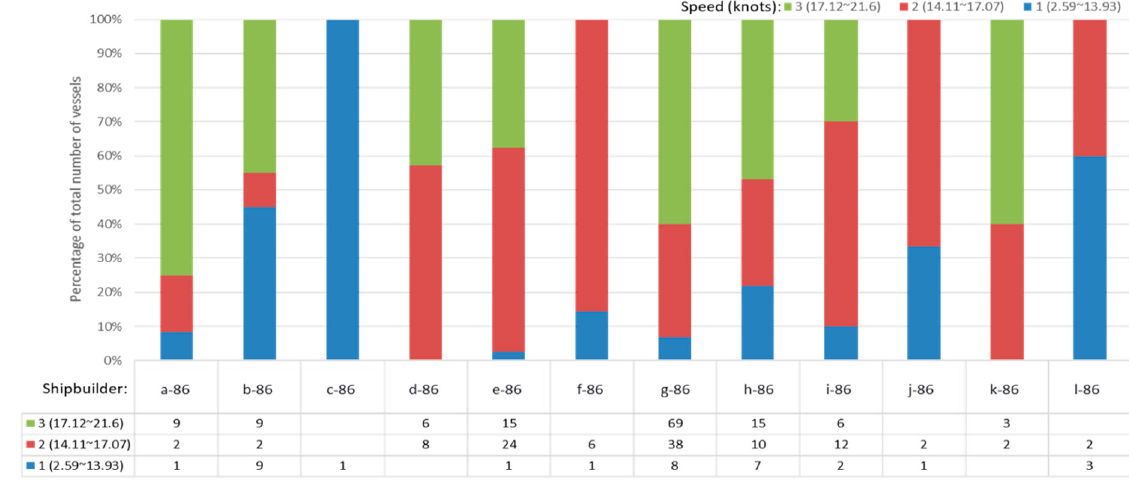
Figure 15. Speed clustering result of the 8600 TEU container ships by shipbuilders.